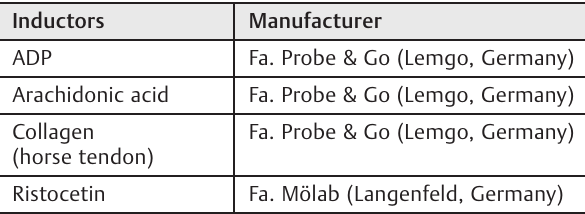
Table 2 Inductor reagents with the respective manufacturers for methods A and B Inductors